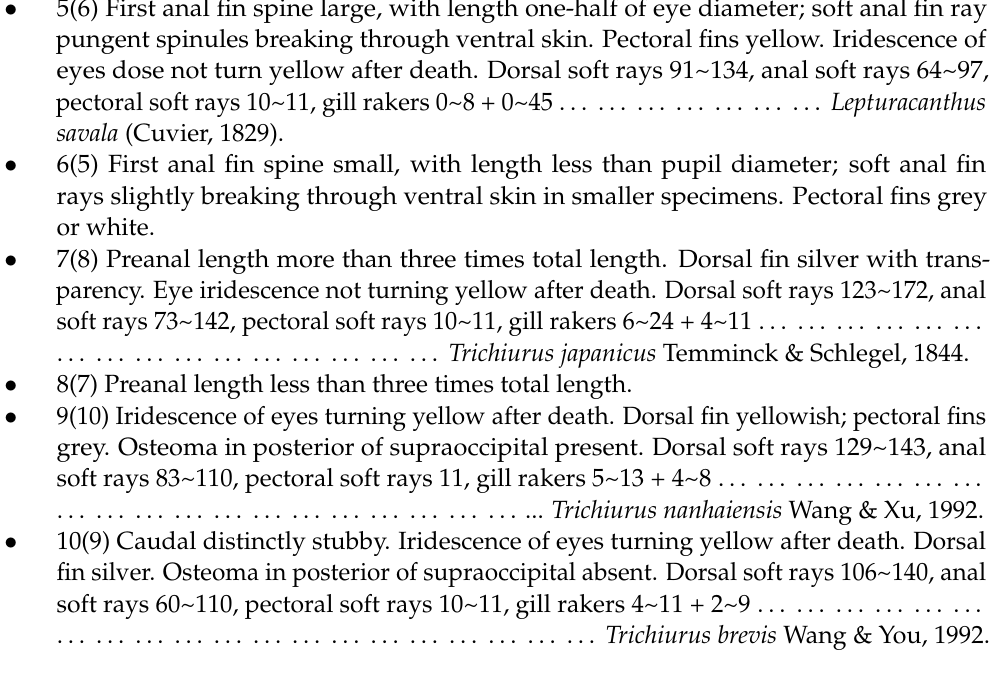
Table A1. Morphological characteristics six hairtail fishes in the coastal waters of China.